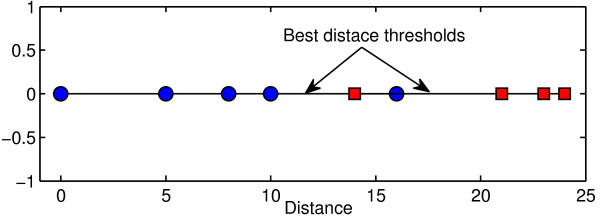
Illustration of the distance threshold. The distance threshold is chosen such that it divides the dataset into two separate groups (red and blue groups). It is clear that there is no unique best threshold. Any threshold between 10 and 14 or between 16 and 21 has only either one false negative or one false positive. However, there is no perfect threshold that separates the datasets into two pure groups.